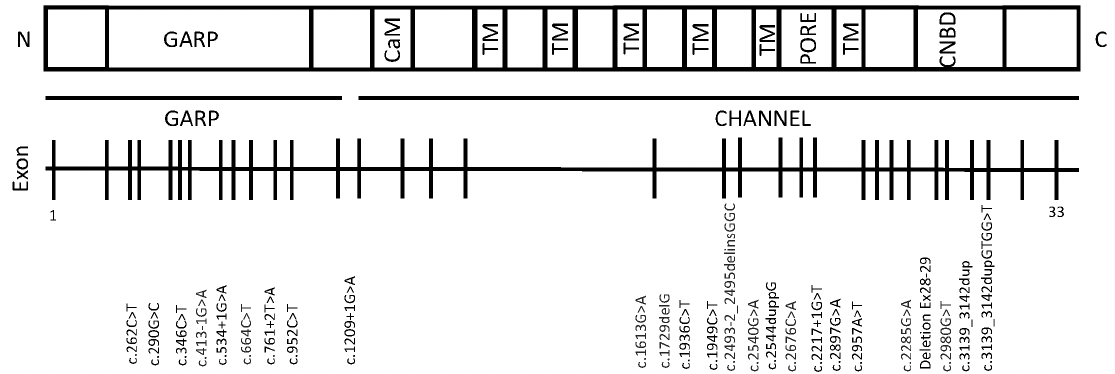
Figure 1. CNGB1 gene and protein schematic with mutations, corresponding to canonical transcript ENST00000251102, NM_001297.5. The protein consists of a glutamic-acid rich protein domain (GARP), a calmodulin - binding domain (CaM), 6 transmembrane (TM) domains, and a cyclic nucleotide binding domain (CNDB).